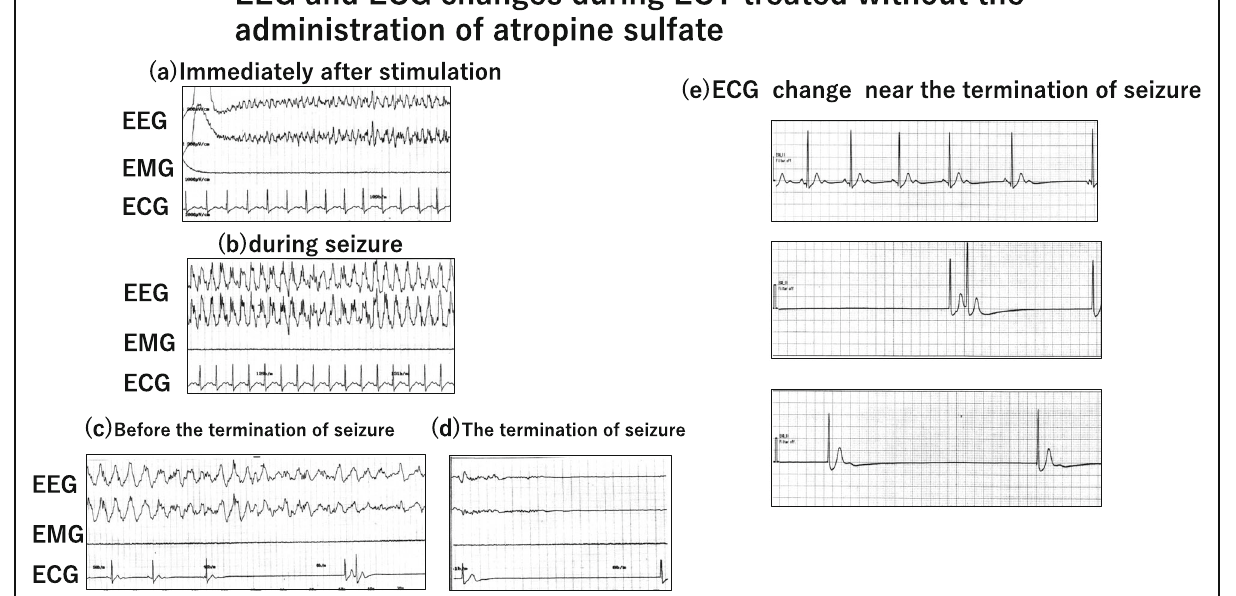
Fig. 1 EEG and ECG changes during ECT without administration of atropine sulfate. a Immediately after stimulation. b During seizure. c Before seizure termination. d Seizure termination. Severe bradycardia is observed from before seizure termination until seizure termination ( c , d